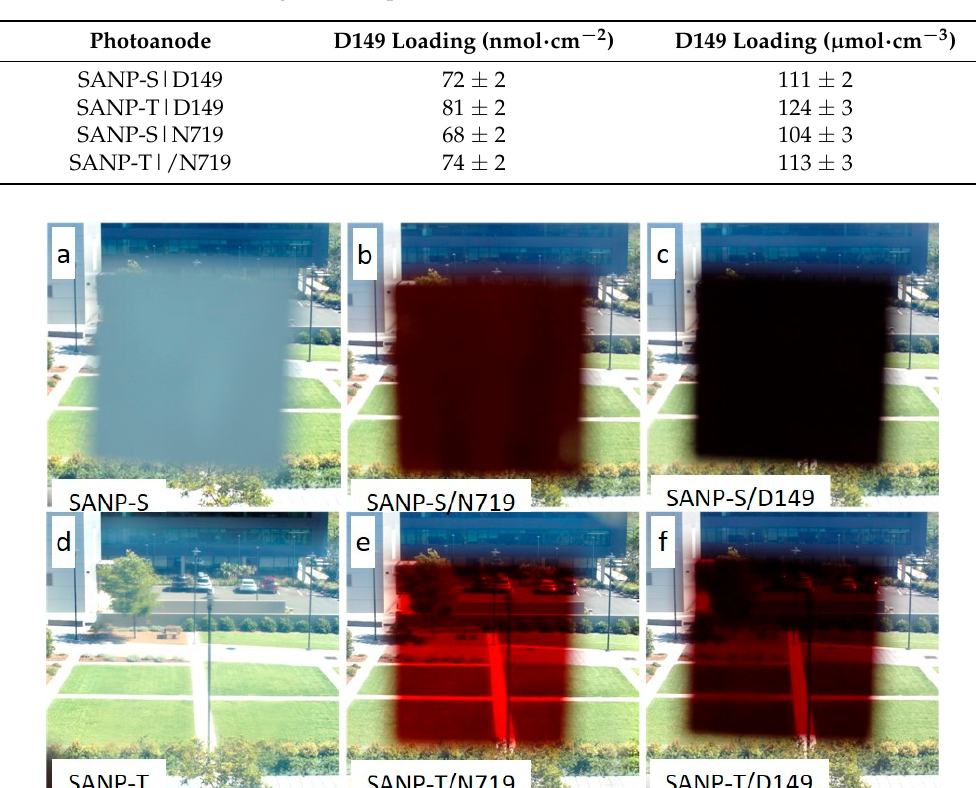
Figure 4. ( a ) and ( b ) Absorbance spectra of dye (D149 or N719) desorbed from either SANP-S or SANP-T films (5.0 ± 0.3 µ m thick, area = 1 cm 2 ); ( c ) Diffuse reflections of SANP-S and SANP-T films (10.0 ± 0.5 µ m thick). Table 1. The amount of D149 dye loading on SANP-S and SANP-T films (thickness = 5.0 ± 0.3 µ m; area = 1 cm 2 ) calculated using the desorption method [31].